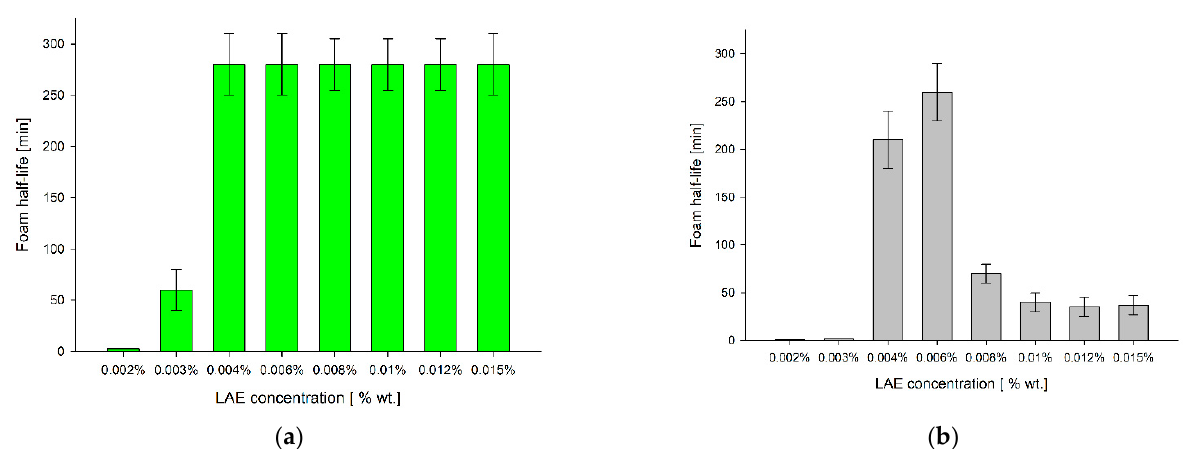
Figure 1. Foam half-life of dispersion of the 0.3 wt.% cellulose nanocrystals with various LAE concentrations; ( a ) cCNC; ( b ) sCNC, (see ref. [21]). Maximum observation time 280 min.